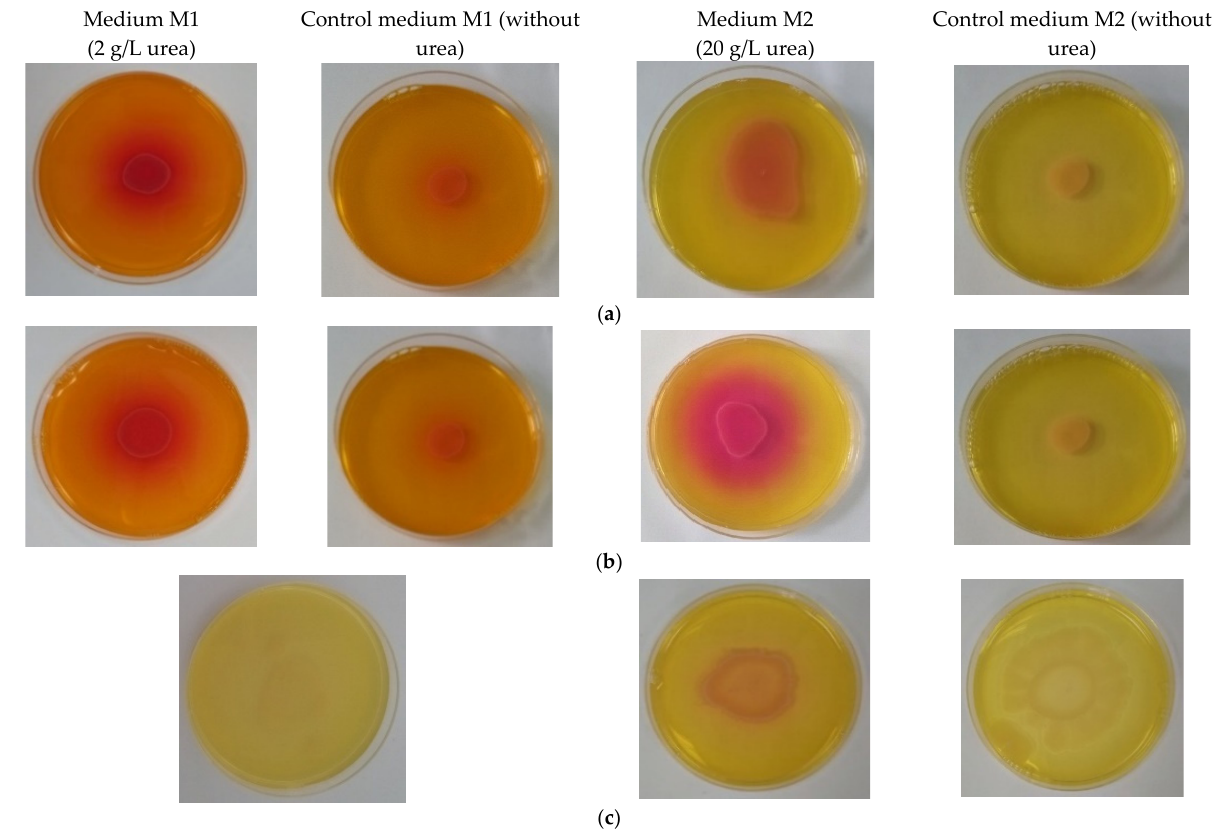
Figure 3. Ureolytic activity of bacterial strains in Petri plates on solid media of different compositions: ( a ) B. licheniformis on media M1, M2 and their corresponding controls (without urea and calcium ions) ; ( b ) B. subtilis on media M1, M2 and their corresponding controls (without urea and calcium ions) ; ( c ) B. amyloliquefaciens on media M1, M2 and their corresponding controls (without urea and calcium ions).